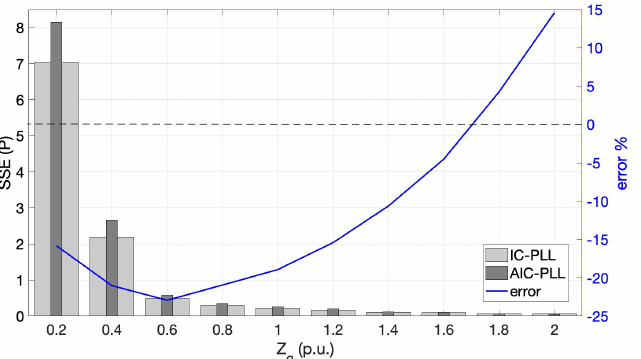
Figure 18. SSE for the active power tracking for the IC-PLL- and AIC-PLL-based system for different change in the values of the grid impedance (inverter operation).